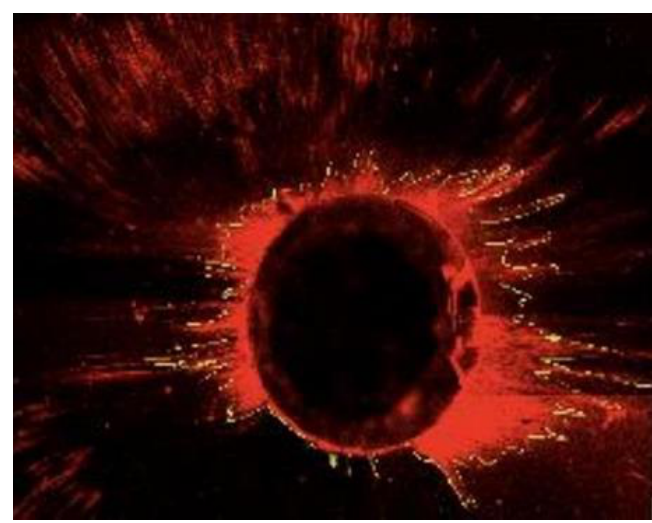
Figure 2. Area of sealer penetration into dentinal tubules measured by ImageJ ® .